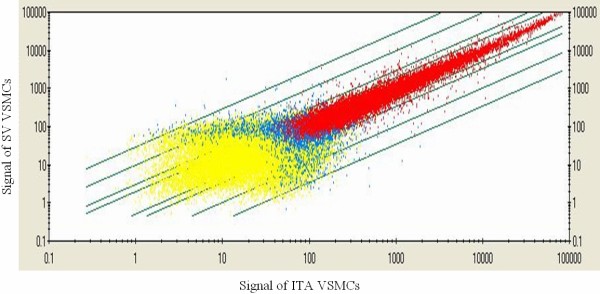
Scatter graph of microarray analysis of gene expression. Fold change Line from diagonal to two side represent 2,3,10,30 fold respectively. Yellow color: Low expression in VSMCs both ITA & SV. Red color: High expression in VSMCs both ITA & SV. Blue color: Differential expression in VSMCs from ITA & SV.